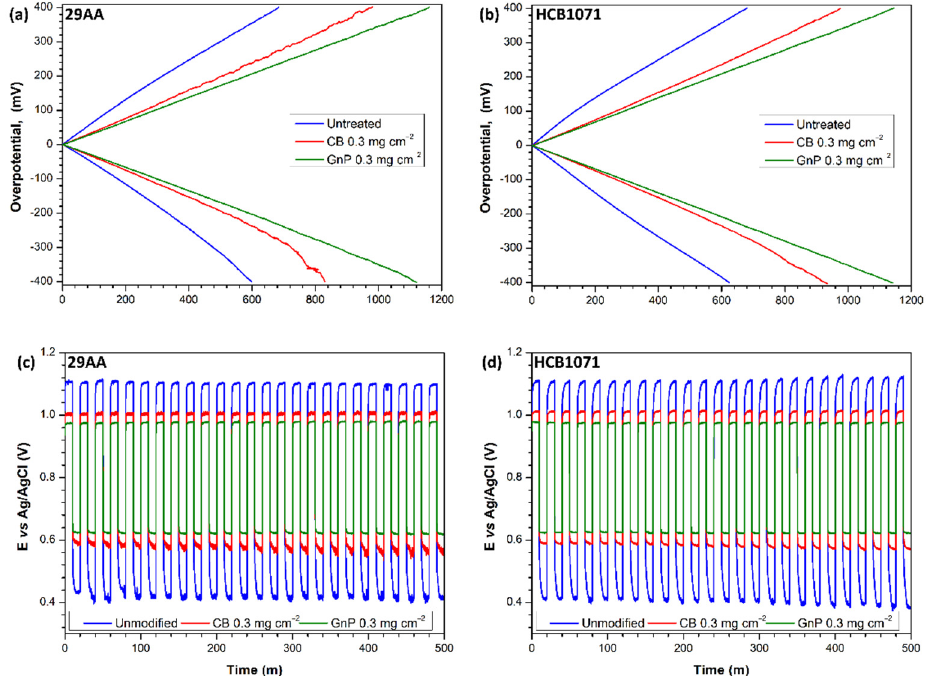
Figure 6. ( a , b ) Polarisation curves and ( c , d ) bromide oxidation/bromine reduction cycling potential responses at ±500 mA cm − 2 for 10 min oxidation, followed by 10 min reduction reaction, obtained on carbon paper (29AA) electrodes ( a , c ) and carbon cloth (HCB1071) electrodes ( b , d ). Electrolyte stirred at 1500 rpm; 3 M HBr/1 M Br 2 electrolyte; temperature, 298 K. The potential responses during oxidation/reduction cycling of bromine